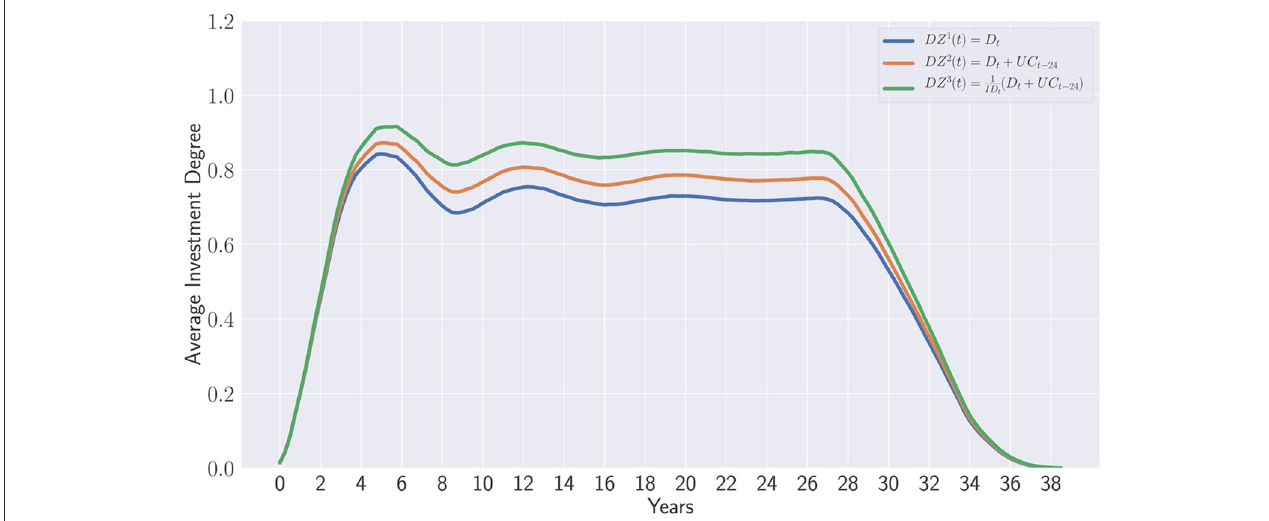
FIGURE11 Simulation of the recommitment strategies described in de de Zwart et al. (2012).